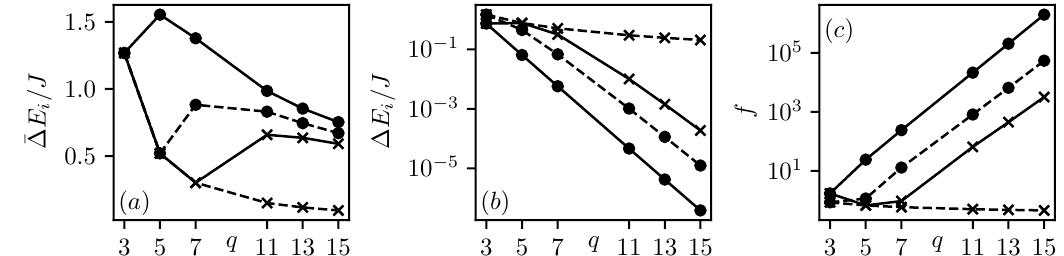
Figure 5: The panels ( a ) , ( b ) and ( c ) show the properties of bands b = 1,2,3, ( q − 1 ) / 2 of HH ( H ) model with φ = 2 π/ q . The bands are marked by HH , , , and respectively. Panel ( a ) shows the bandgap ¯ ∆ E boring band, and Panel ( b ) — the bandwidth ∆ E f for the same